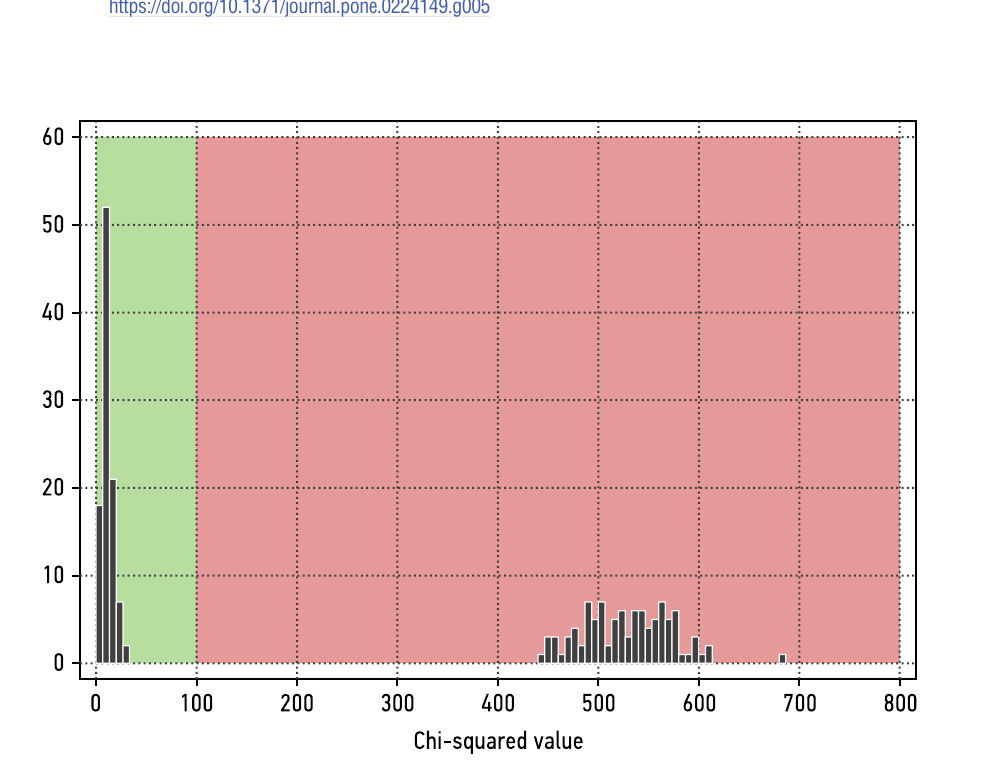
¼ 100 , would have to be negotiated by the parties to meet T